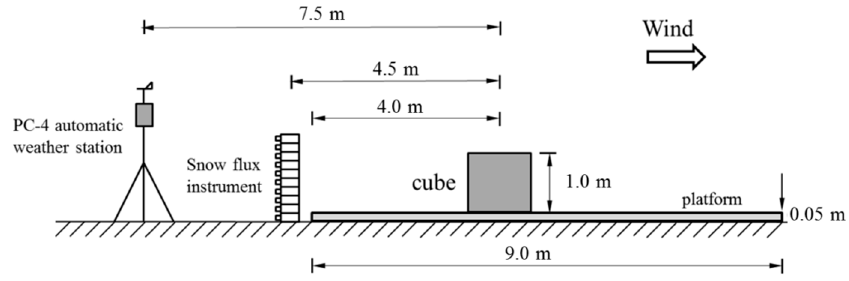
Figure 9. Abridged general view of field observation.